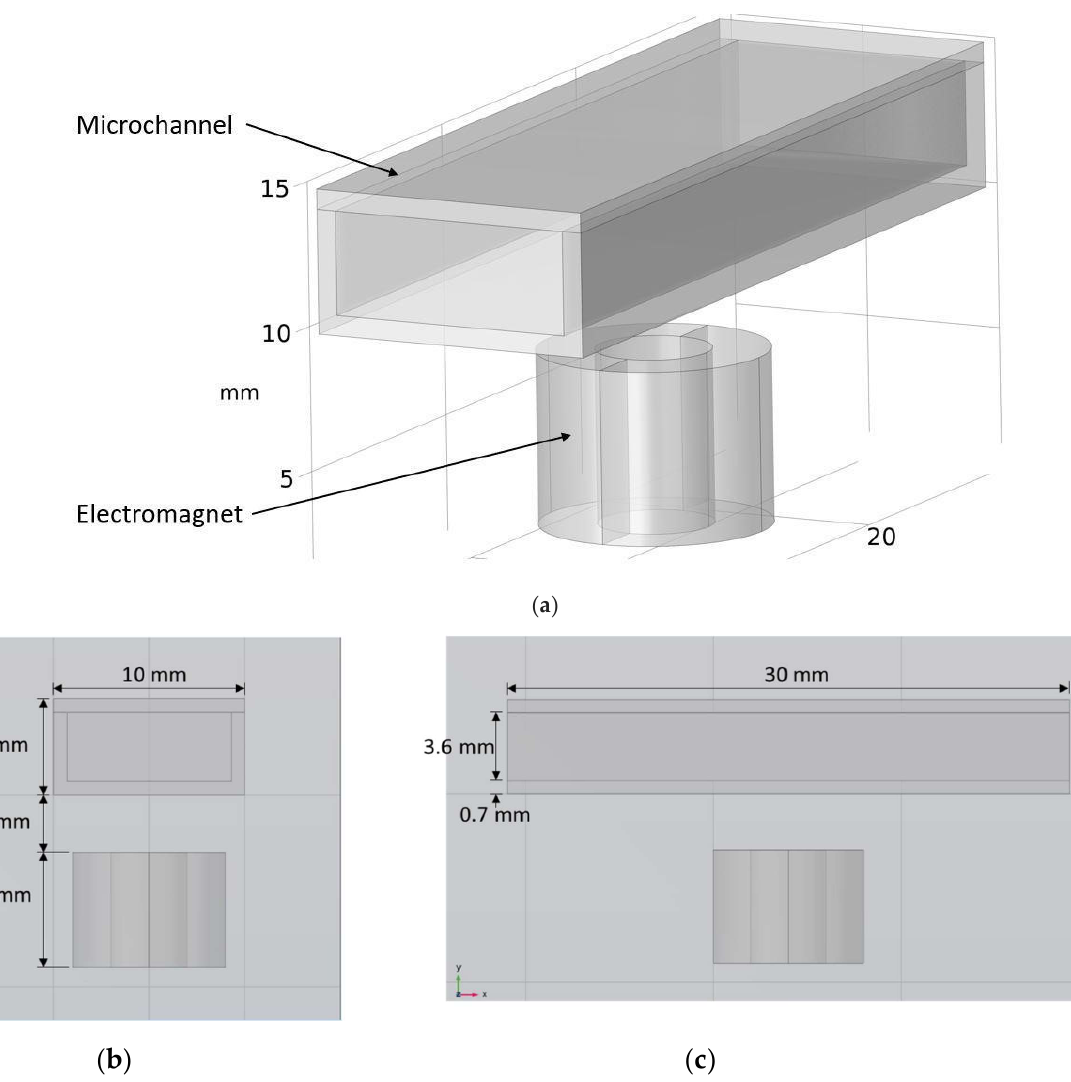
Figure 7. Schematic of the model studied in [31]: ( a ) 3D view. ( b ) Front view. ( c ) Side view.